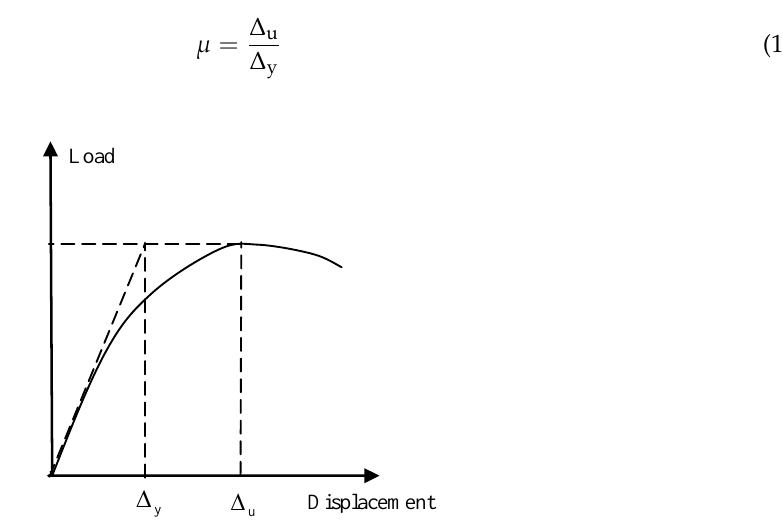
Figure 15. Trilinear substitute model of envelope curves.